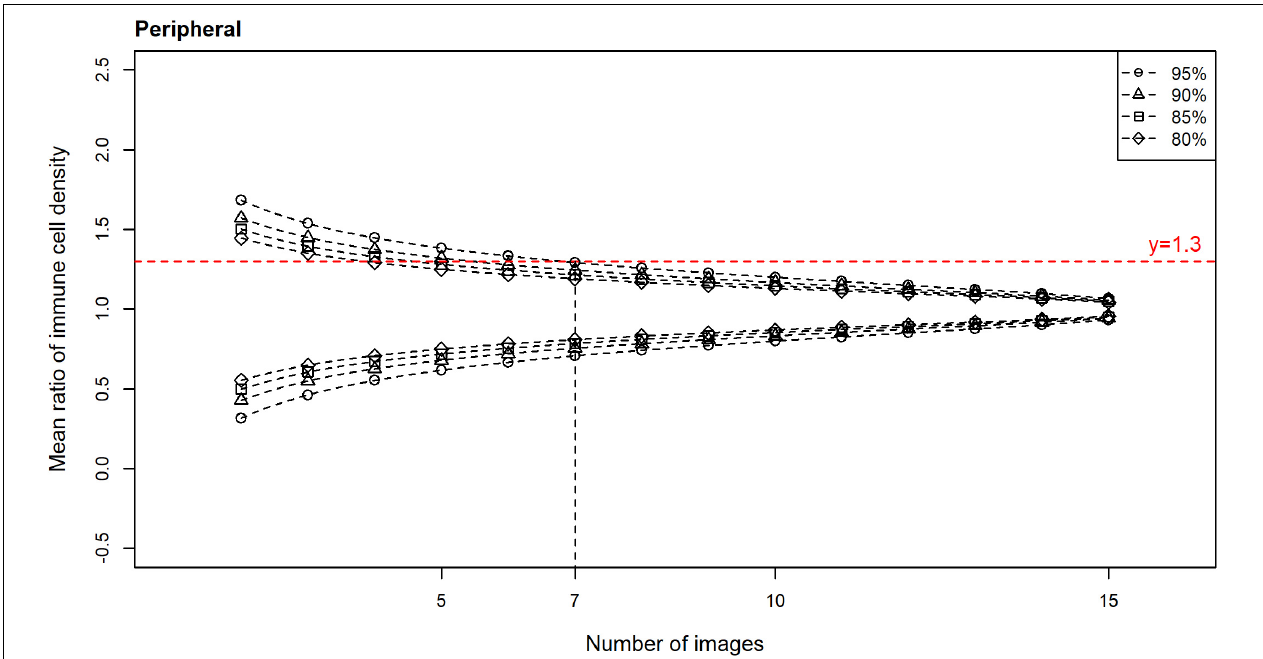
FIGURE 5 | Confidence intervals (CIs) with 80, 85, 90, and 95% levels of confidence for the mean ratio for corneal epithelial immune cell (IC) density relative to the number of randomly selected, non-overlapping images used for IC density estimate, for all participants for the peripheral cornea. Horizontal line (mean ratio = 1.3) indicates the location where the estimated mean is 30% different from the true mean in the distributions. Vertical line (number of images = 7) indicates the number of images that is predicted to produce estimated means that are 30% different from the true mean (i.e., mean ratio = 1.3 or 0.7), at a confidence level of 95%, for the peripheral cornea.